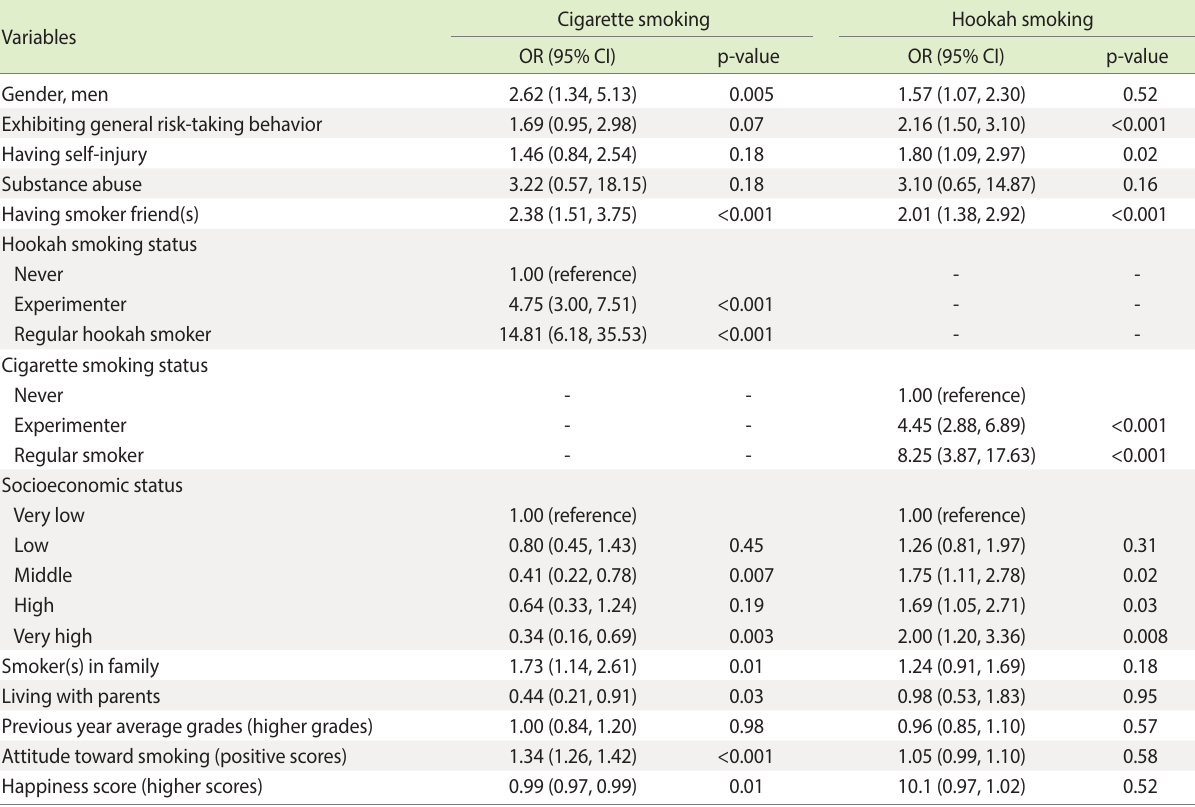
Table 3. Ordinal logistic regression analysis of the relationships of cigarette smoking and hookah smoking status with risk variables